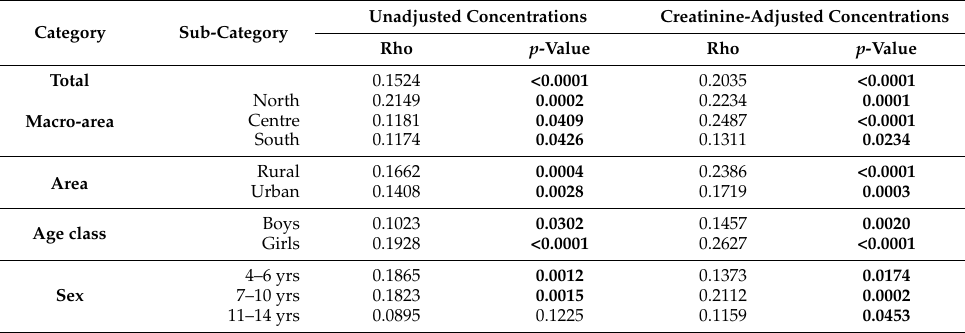
Table 5. Spearman correlations between BPA and sum of DEHP metabolite levels in urine samples of Italian children ( N = 900) for both unadjusted ( µ g/L) and creatinine-adjusted urinary concentrations ( µ g/g) considering the different residing Italian macro-areas and areas, sex and age categories. Rho coefficients and p -values (Bonferroni corrected) are reported; significant p-values are in